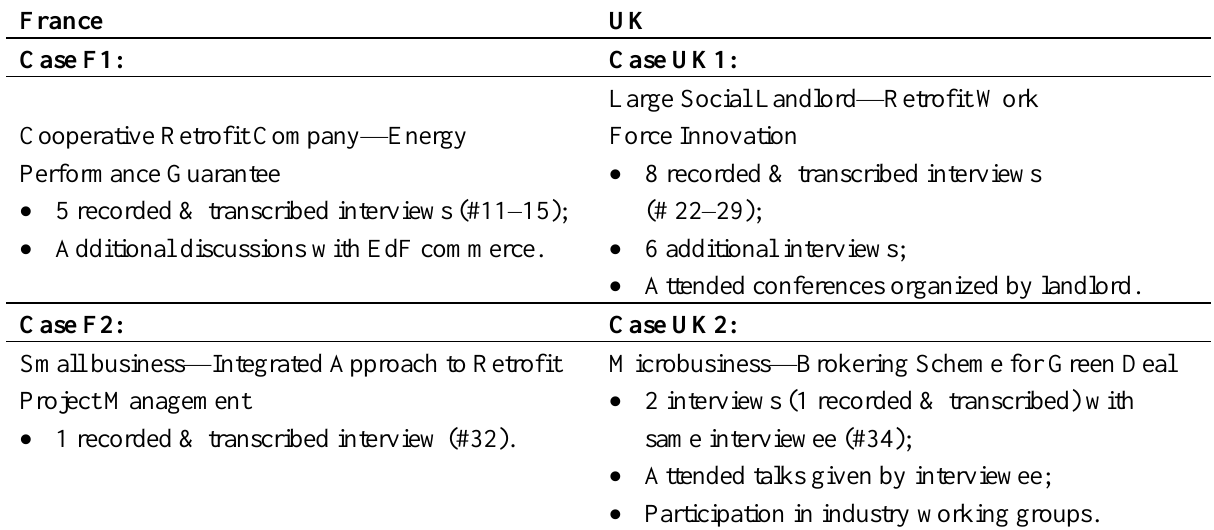
Table 1. Building expertise case studies: data from innovative